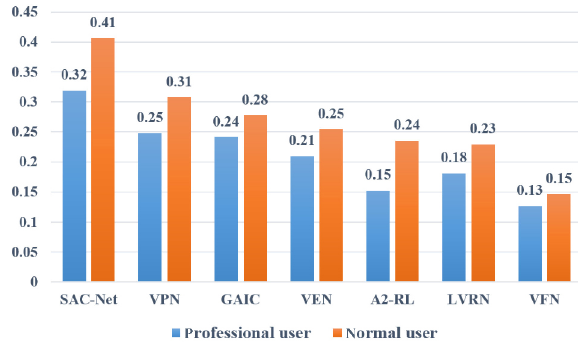
Fig. 8 User study results for single-object images using the SACD dataset test set.